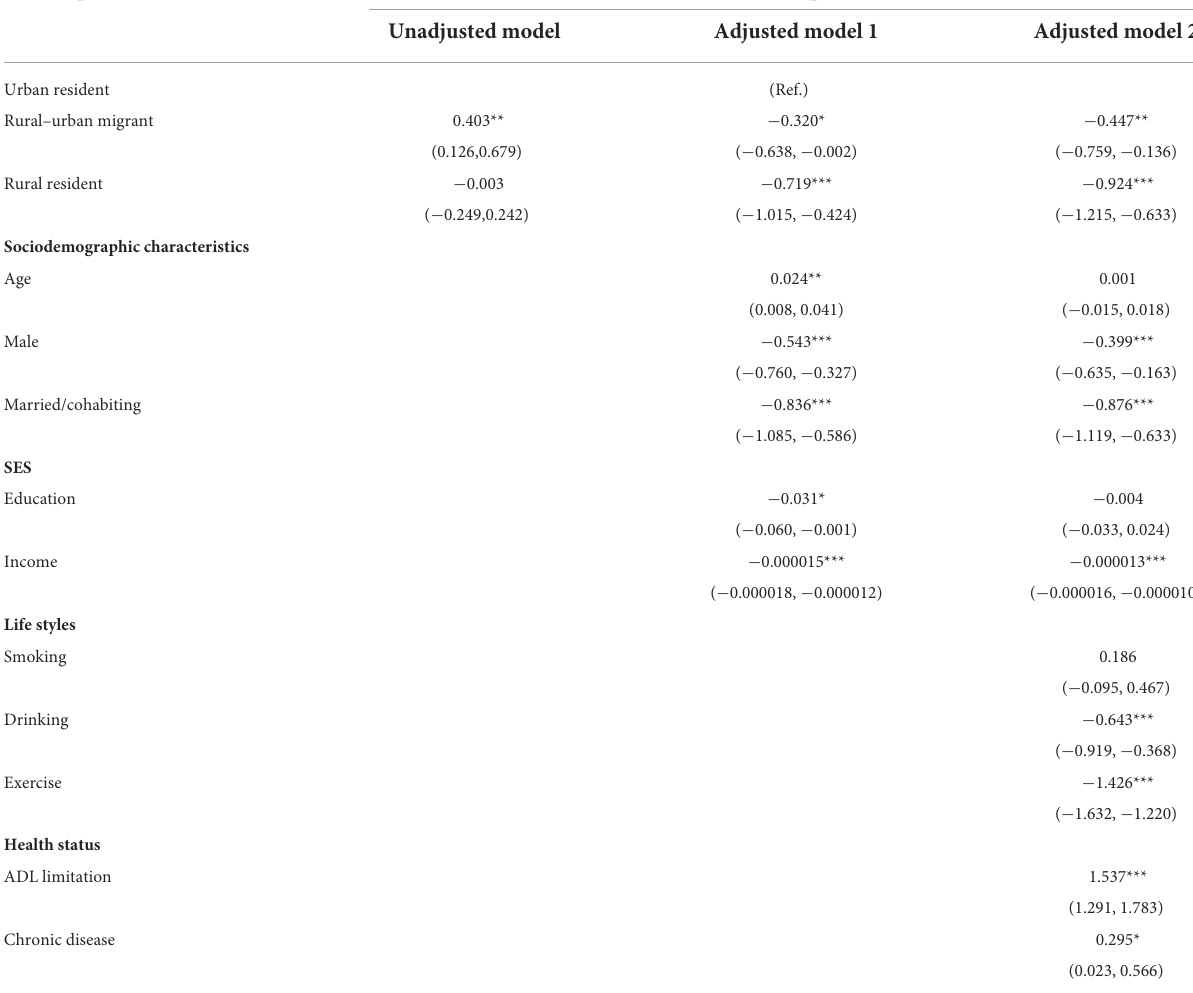
TABLE 3 Ordinary least squares regression for main residential location and total depressive symptom score